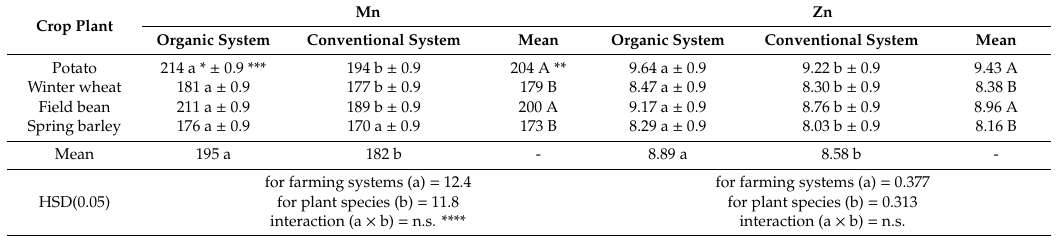
Table 12. Manganese and zinc content (in mg kg − 1 ) in the 0–25 cm soil layer. Crop